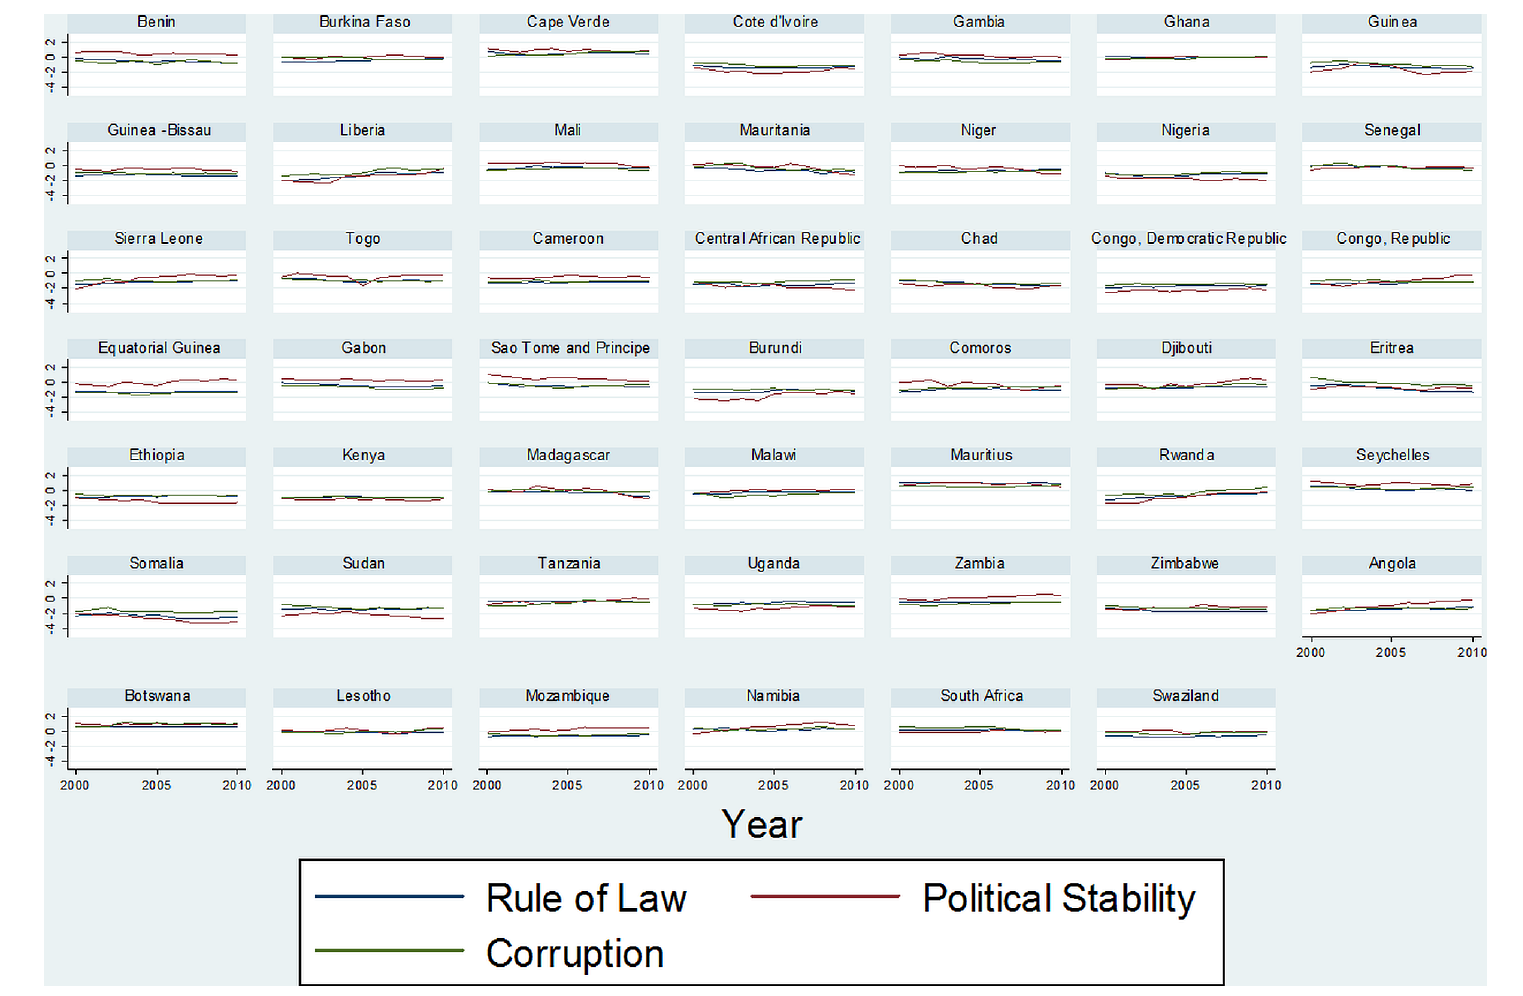
Figure 3. Changes in good governance,